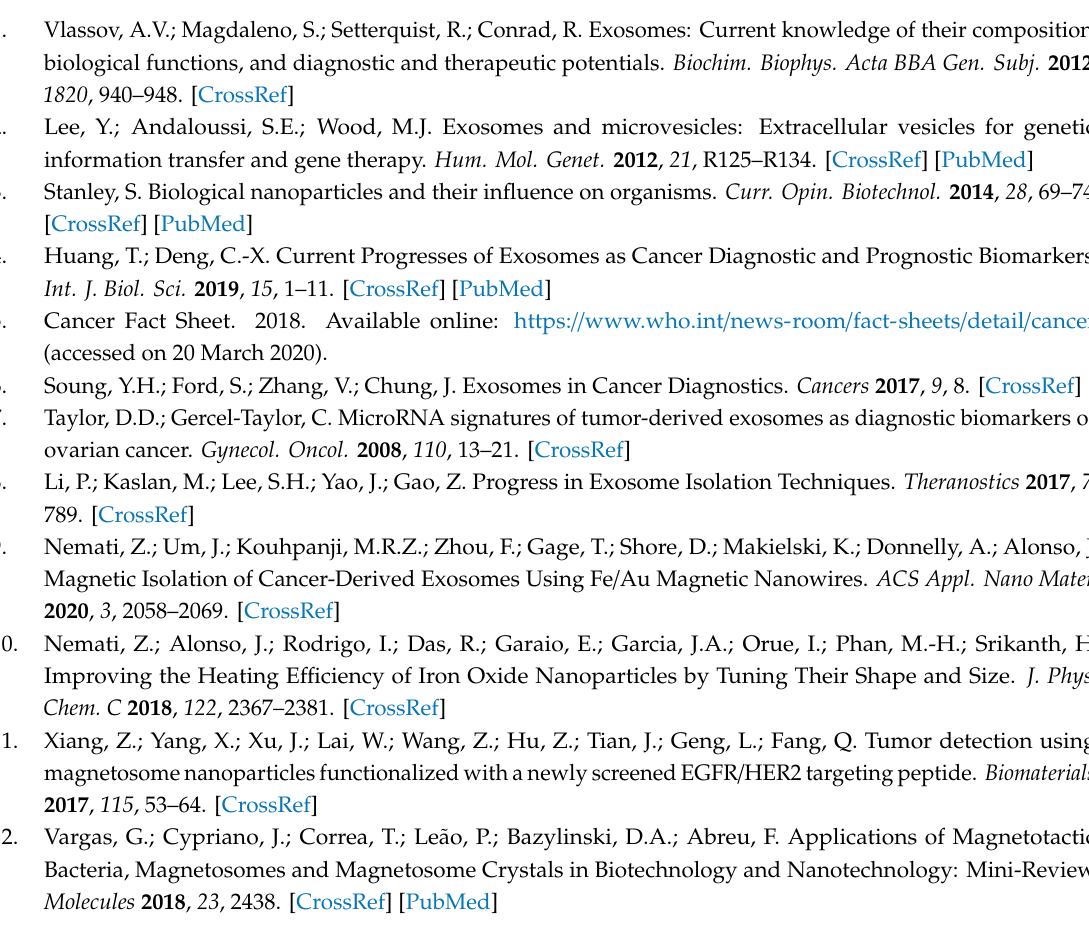
Figure S1: TEM images of internalized MNWs and MGs in OSCA-8 cells, Figure S2: TEM images of non-internalized MNWs, Figure S3: TEM images of internalized MNWs and MGs, and Figure S4: TEM images of Magnetically Isolated